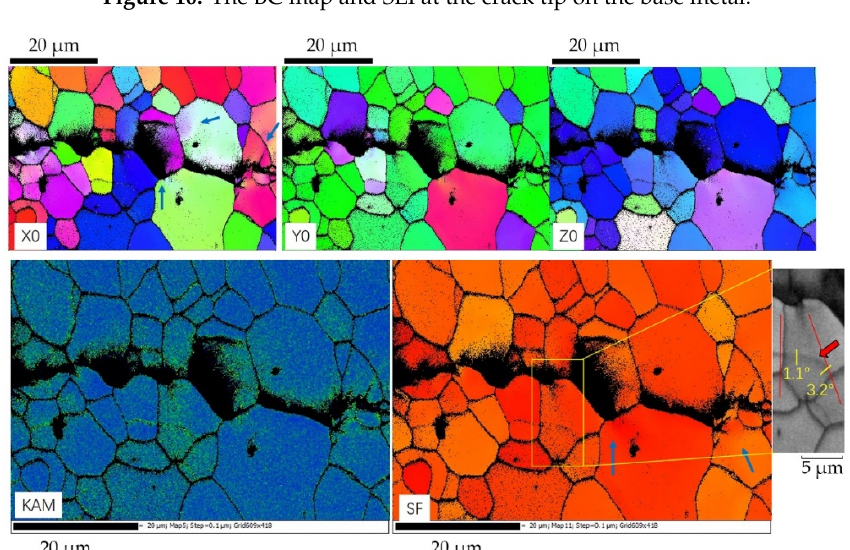
Figure 10. The BC map and SEI at the crack tip on the base metal.